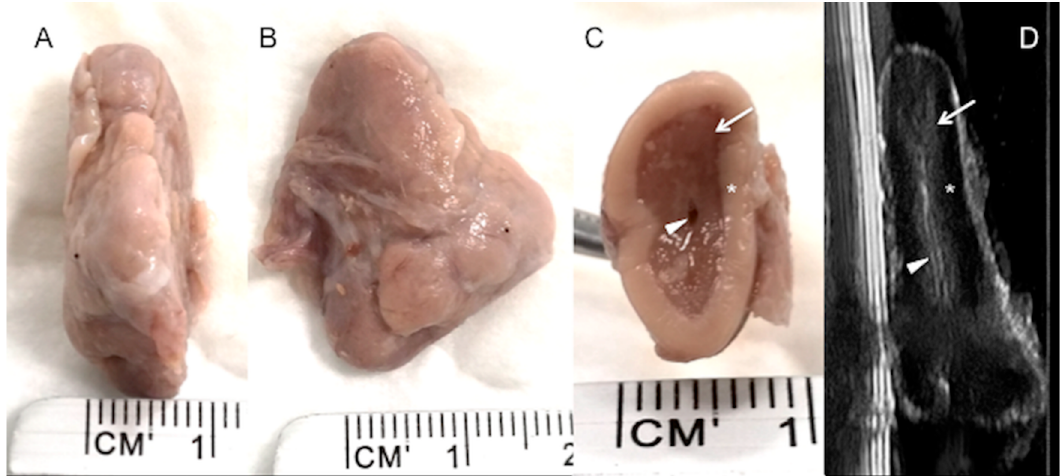
Figure 4. A right adrenal gland from a dead calf. ( A ): transverse view, ( B ): dorsal view and ( C ): cross section at a mid-point. ( D ) corresponds to an ultrasound image through a mid-sagittal cross section of the same adrenal gland held in a water bath, before dissection. Adrenal cortex (*) and medulla (white arrow) are clearly defined in both ( C ) and ( D ), with the hypoechoic cortex and echoic medulla. Small vessels were identified in this specimen (white arrowhead), but not in the in vivo ultrasound.